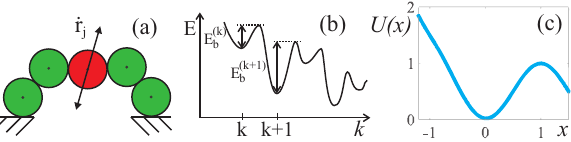
Figure 2. Trap model for the energy landscape of arch confi- gurations. (a) Beads in the arch explore di ff erent configurations by minute displacements; (b) Each stable configuration can be thought of as a point at the bottom of a potential well; each well k corresponds to one arch, and the whole set of arches describe an energy landscape (c) A generic energy barrier used in the nu- merical simulations. Figure adapted from